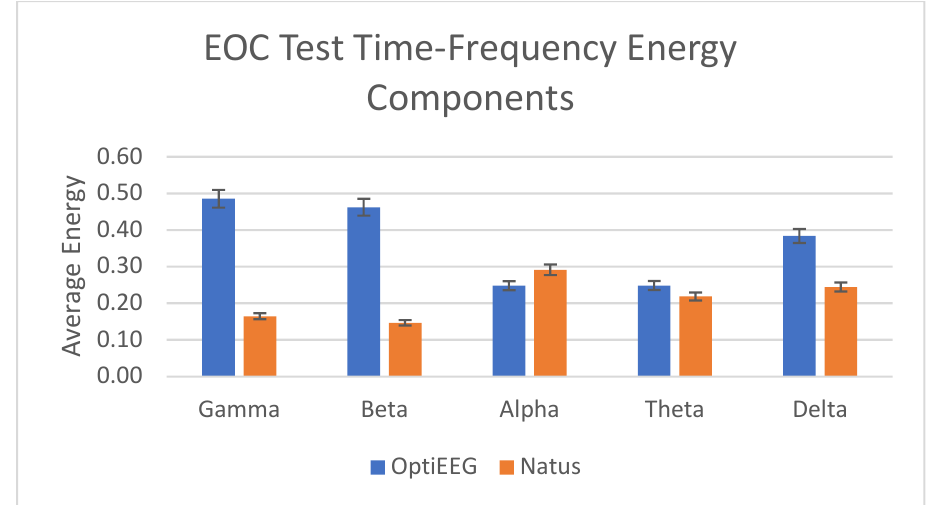
Figure 13. Power of time–frequency components for EOC test. HV is a standard activation method practiced in routine EEG recording among epilepsy patients [64]. HV is a condition where a person breathes faster and deeper, which can lead to changes in brain activity, including a bifrontal preponderance pattern. The activation technique generally results in a physiological slowing of brain rhythms. The typical HV response in EEG shows moderate to high voltage, often rhythmic with delta and theta slowing in conjunction with bifrontal preponderance [61]. Bifrontal preponderance is a term used in EEG to describe an abnormality in the distribution of electrical activity in the brain. Specifically, it refers to an excessive amount of activity in the frontal lobes of the brain relative to the posterior regions. In this study, the HV test is used as a validation method to verify the capacity of OptiEEG in capturing HV response in comparison to the Natus EEG device, as in Figure 14.